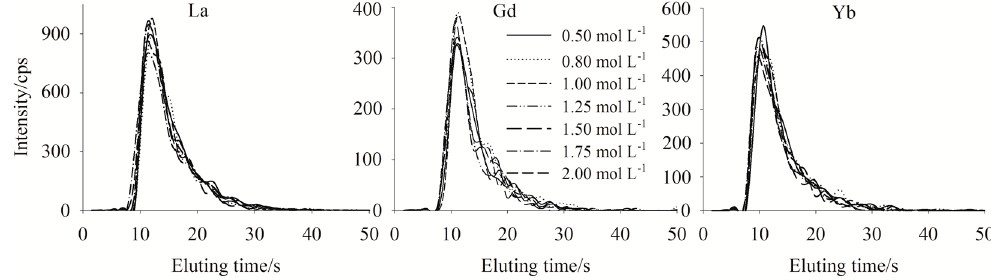
Figure 2. Elution profiles for La, Gd and Yb when eluted with different concentrations of HNO 3 ; test sample salinity = 33.